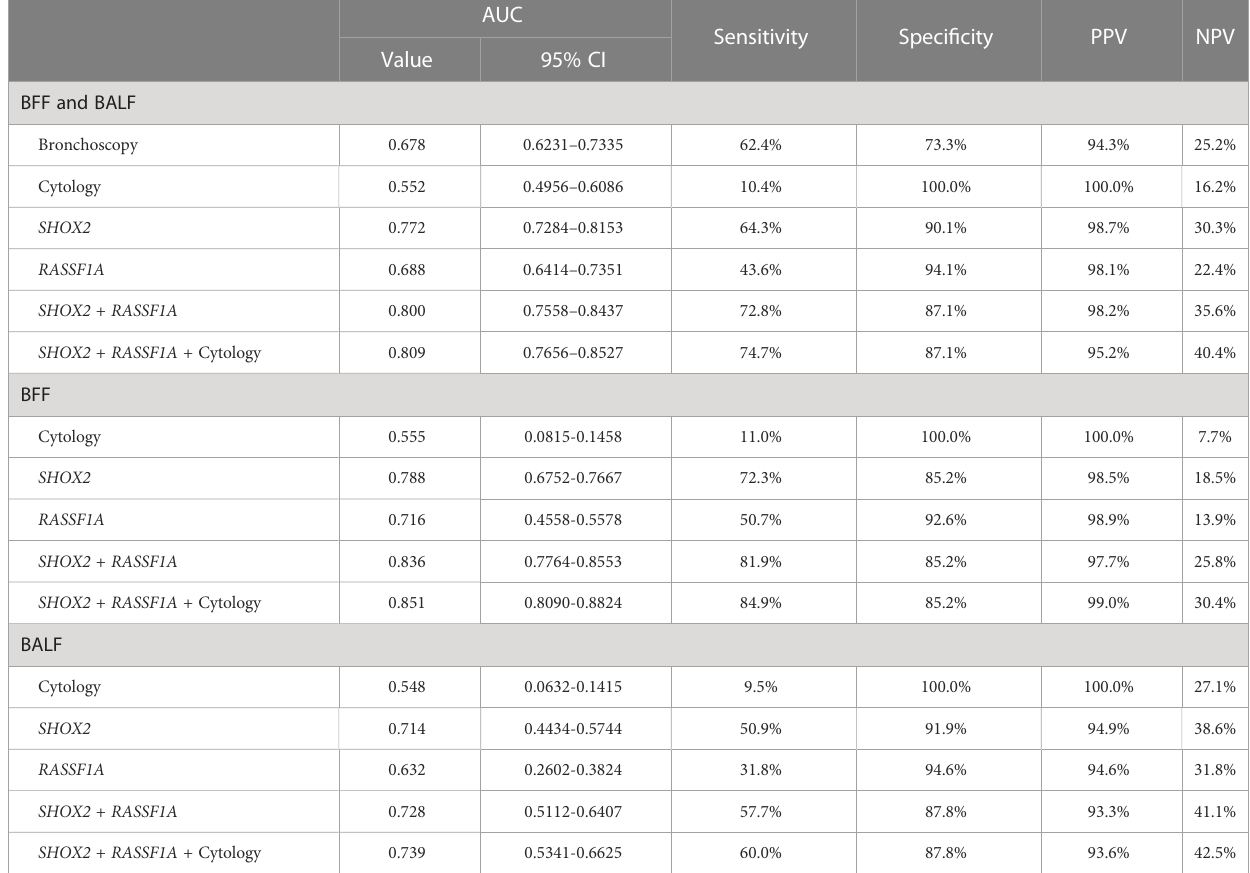
TABLE 4 The diagnostic ef fi cacy of bronchoscopy, cytology, SHOX2 and RASSF1A methylation